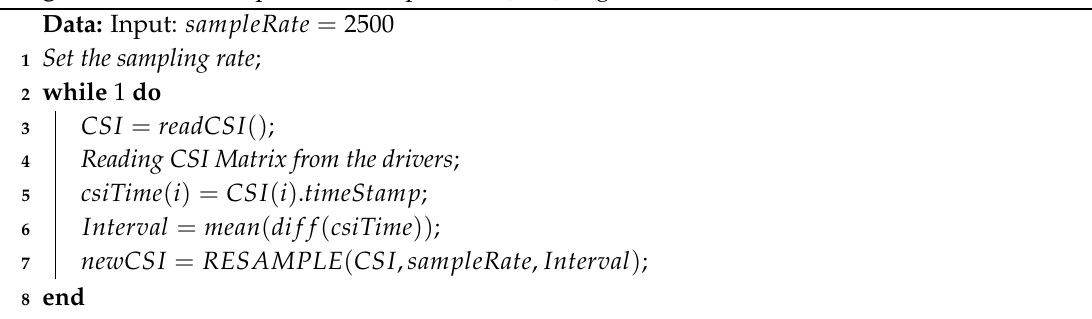
Algorithm 1: Time-dependent Interpolation (TDI)